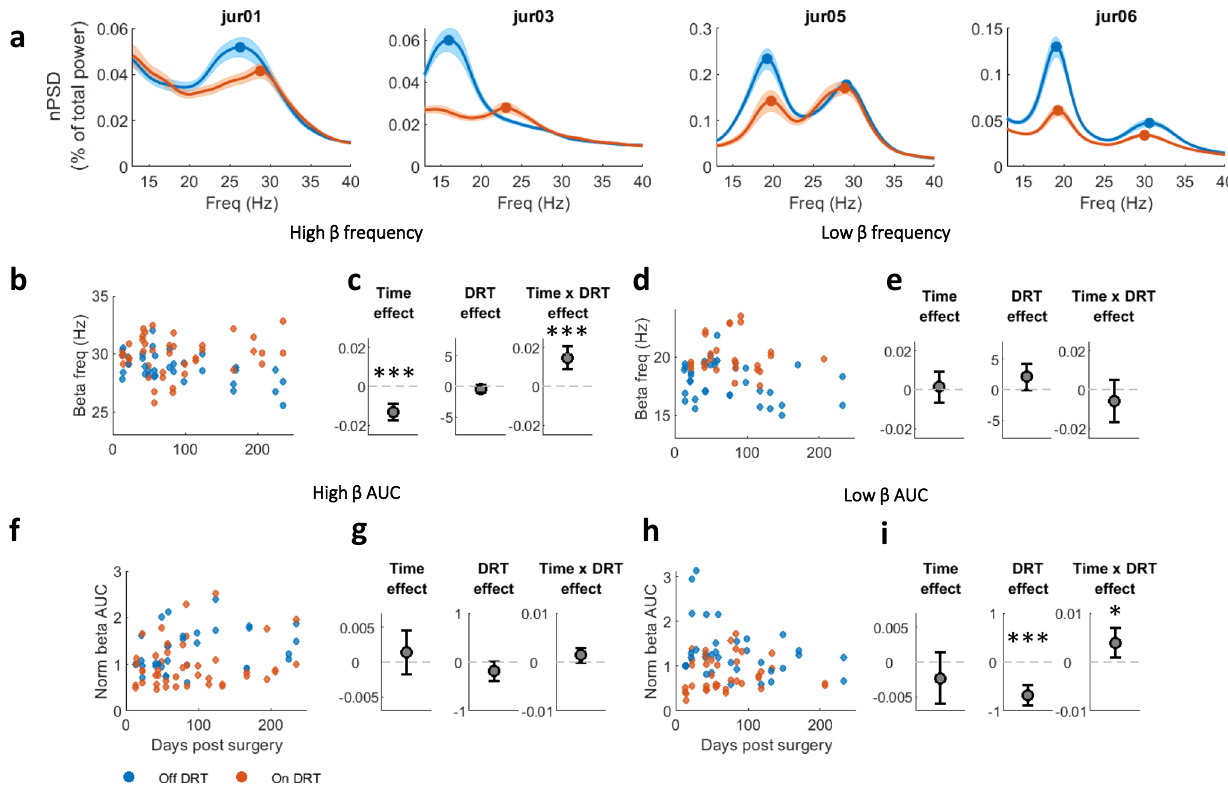
Fig. 7 Dopamine modulation shifts STN LFP beta-frequency in patients with PD. a normalized PSD (mean ± STE) off (blue) and on (red) dopamine- replacement therapy (DRT) in each patient. b , d Beta-peak frequency in high ( b )/low ( d ) beta-domains as function of time post-surgery. Each point represents average per day of beta peak-frequency in one STN on (red) and off (blue) DRT condition. c , e Time, DRT, and interaction effects on beta-peak frequency as estimated by a mixed linear effect model (MLEM), constructed for N = 466 and 418 independent recordings for high-beta frequency ( c ) and low-beta frequency ( e ) models, respectively. Only pairs with signi fi cant beta peak were included in the model. Time ( p = 1.1e-8) and time*DRT interaction ( p = 6.8e-7) had signi fi cant effect on high-beta frequency. Gray circles indicate each factor ’ s coef fi cient in the MLEM, and whiskers indicate con fi dence intervals. Positive and negative coef fi cients indicate positive and negative linear relation, respectively. In the interaction effect, the coef fi cient presented is of time given on DRT condition. f – i Time and DRT effects on beta-power in the high ( f , g ) and low ( h , i ) beta-domains. Plot conventions same as ( b – e ). Beta-power evaluated as baseline-corrected area under the curve (AUC) of normalized PSD in the high ( f – g ) and low ( h – i ) beta-domains. MLEM was constructed for N = 740 and 669 independent recordings for high-beta AUC ( g ) and low-beta AUC ( i ) models, respectively. DRT ( p = 2.9e-10) and time*DRT interaction ( p = 0.012) had signi fi cant effect on low-beta AUC. The signi fi cance of the fi xed effects was estimated with ANOVA test (Table- S13). Source data are provided as a Source Data fi le. * p < 0.05, ** p < 0.01, *** p <